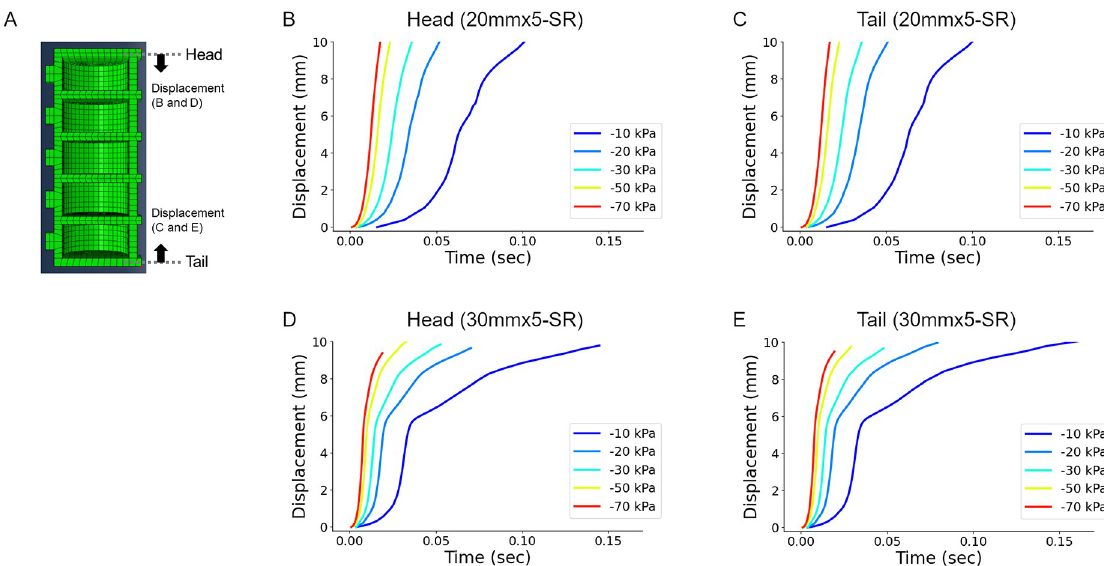
Fig 5. Simulation of the soft robots by FEM. (A) Section view of the soft robot generated in Abaqus. The displacements of the head and tail were monitored. (B-C) Displacements of the head (B) and tail (C) of the 20mmx5 soft robot during the simulated contraction of the corresponding segment. (D-E) Displacements of the head (D) and tail (E) of the 30mmx5 soft robot during the simulated contraction of the corresponding segment. The internal pressures were tested from -70 kPa to -10 kPa.